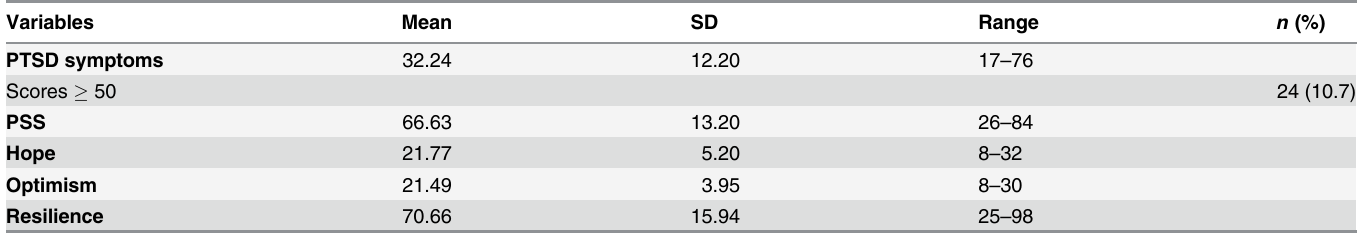
Table 2. Descriptive statistics for PTSD symptoms, PSS, hope, optimism and resilience.